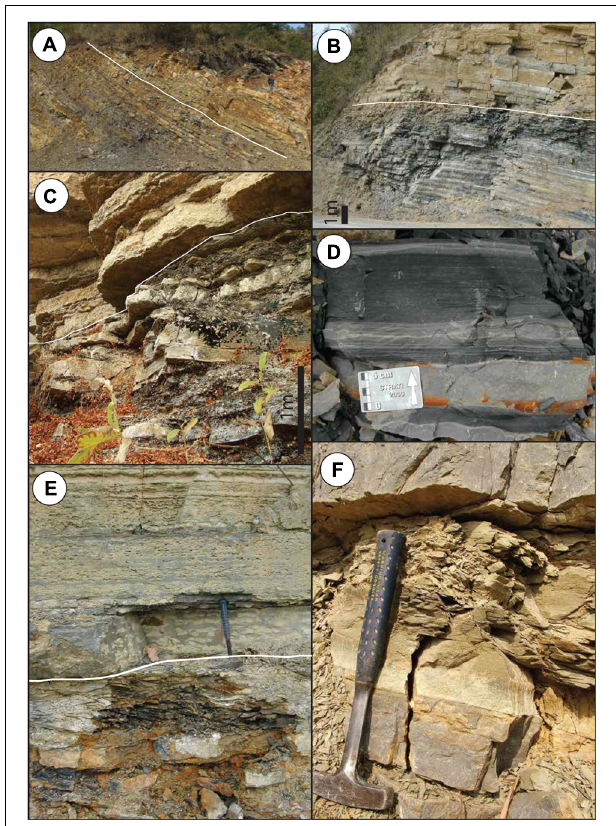
FIGURE 2 | Field photographs of the Smithian-Spathian boundary (SSB); white lines indicate the position of the boundary between units Vb and Va; (A) Qiakong section; topmost part of Daye Fm visible in lower left corner (person for scale); (B) Laren section; (C) Lilong section; (D) close-up of the Laren section, typical facies of unit IVb, with laminated black shale and rare, thin intervening gray limestone ( Anasibirites multiformis / Xenoceltites pauciradiatus Zone); (E) Laren section, close-up view of the boundary between units IVb and Va; and (F) Laren section, ash layer CHIN10, note positive grading within the ash layer; for (E) and (F) hammer for